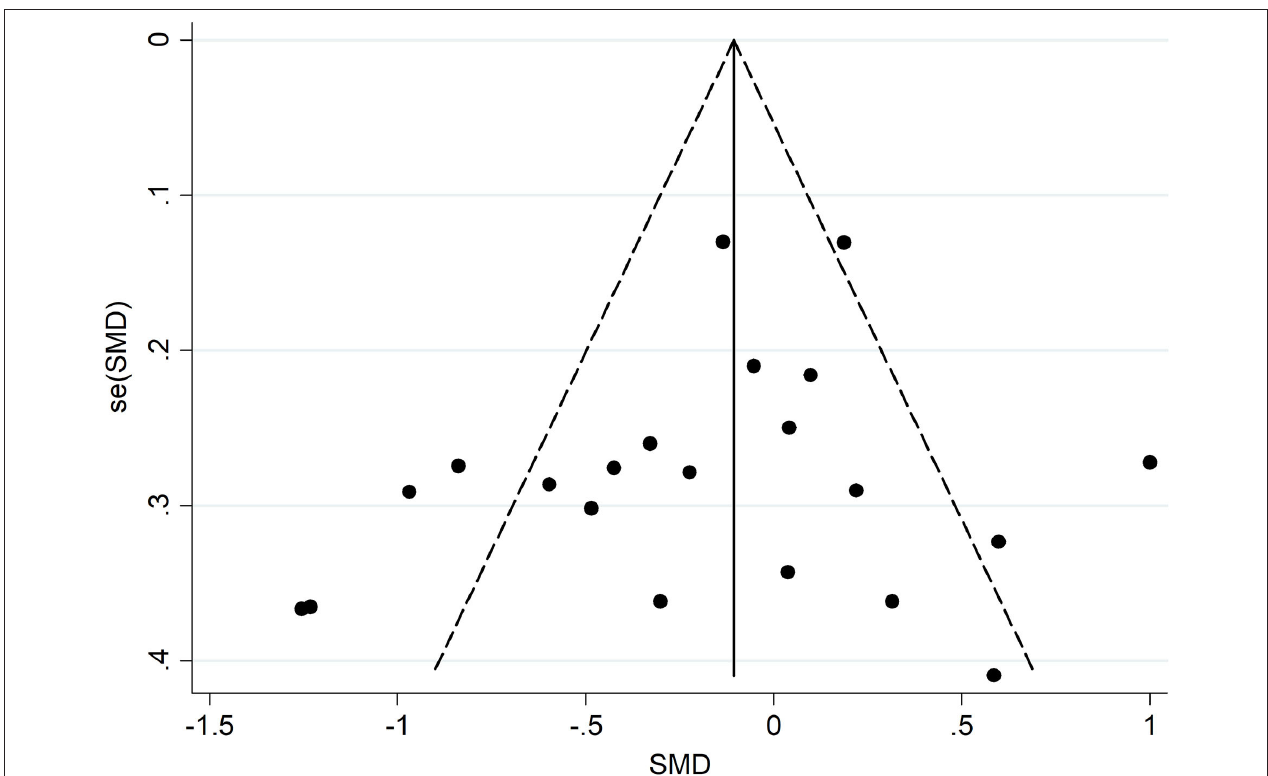
FIGURE 4 | Funnel plot analysis. SMD, standardized mean difference; SE, standard